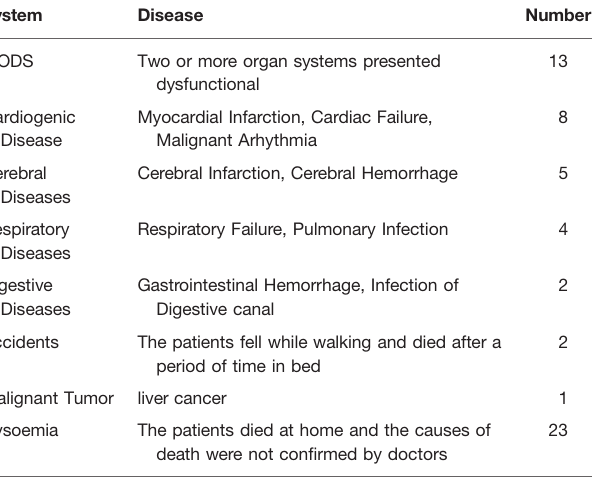
TABLE 1 | The main causes of 58